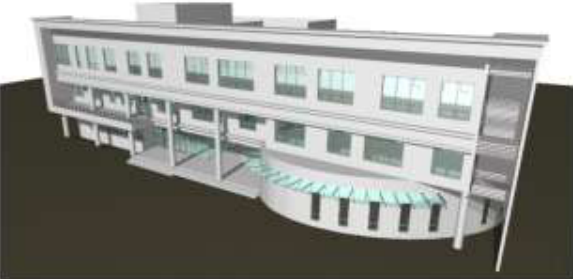
Figure 13. 3D Model of Koica Building (LOD 3)